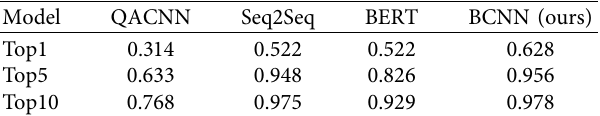
Table 1: Experimental results of semantic matching model effect comparison (accuracy).